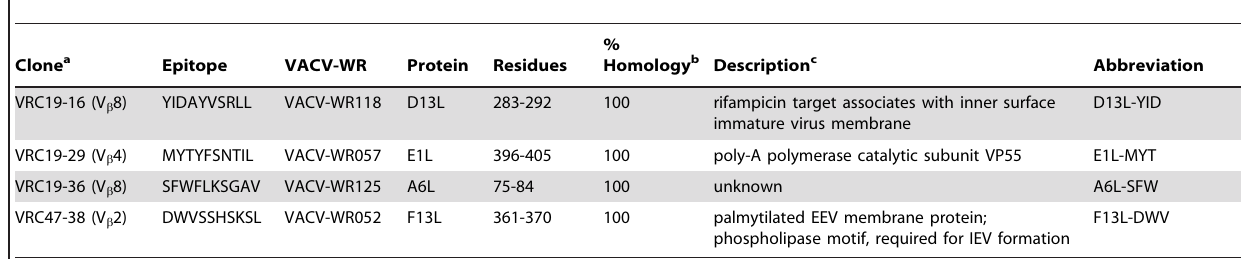
Table 1. Characteristics of identified vaccinia CD4 + epitopes.